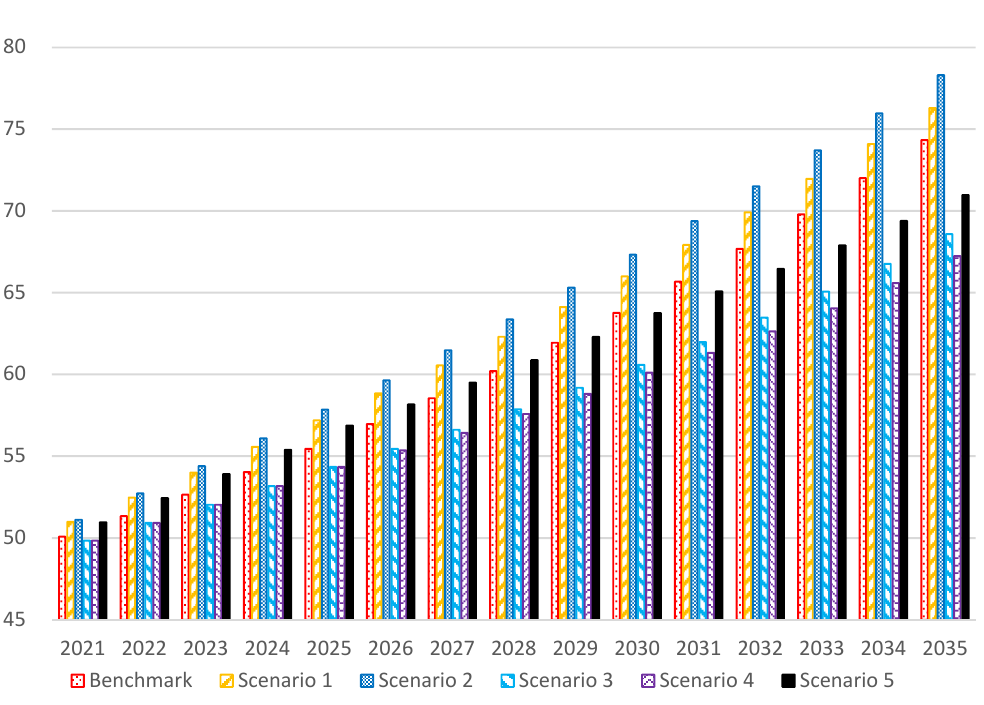
Figure 1. Simulation of energy consumption in different scenarios (100 million tons of standard coal).